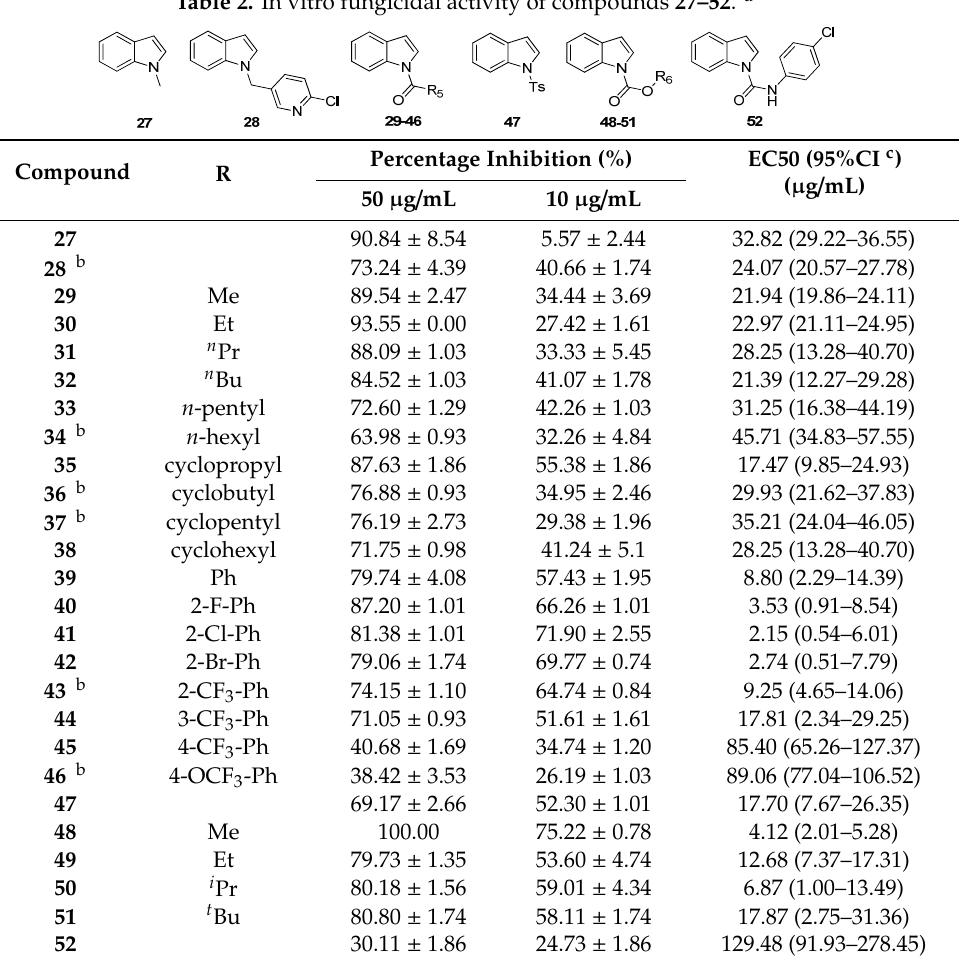
Table 2. In vitro fungicidal activity of compounds 27–52 . a